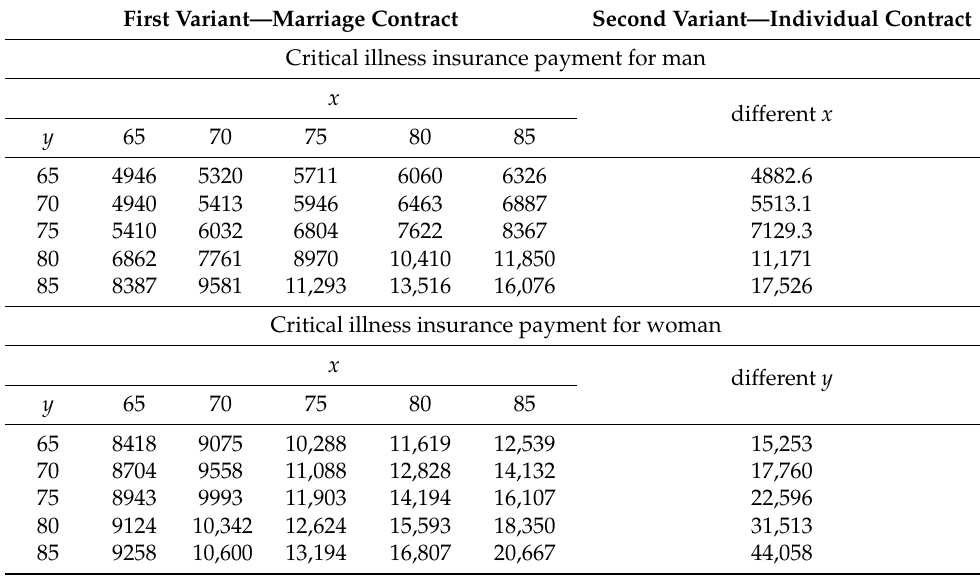
Table 5. Critical illness insurance payment depending on the age of spouses in two variants of